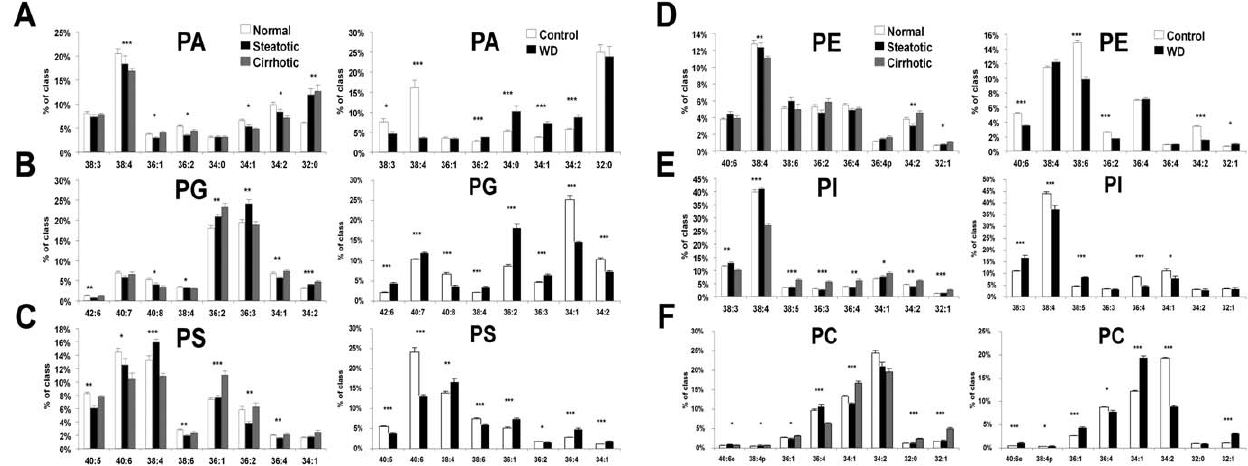
Figure 2. Selected glycerophospholipid species distribution from human and murine livers. (A, B, C, D, E, F) Data from humans ( represented in graphs on left side of lettered panels)(black bars: normal; open: steatotic; hatched: cirrhotic) for phosphatidic acid (PA), phosphatidylglycerol (PG), phosphatidylserine (PS) classes, respectively; n=5–9 individuals per group. Graphs on right side of each panel demonstrate results in mouse model (black bars: control; open: WD); n=3 individual mice per group. Error bars=sem. Asterisks indicate Bonferroni adjusted significance at better than the *p , 0.05, **p , 0.01, ***p , 0.001 levels from ANOVA across disease states for human data and from Student’s t test for murine